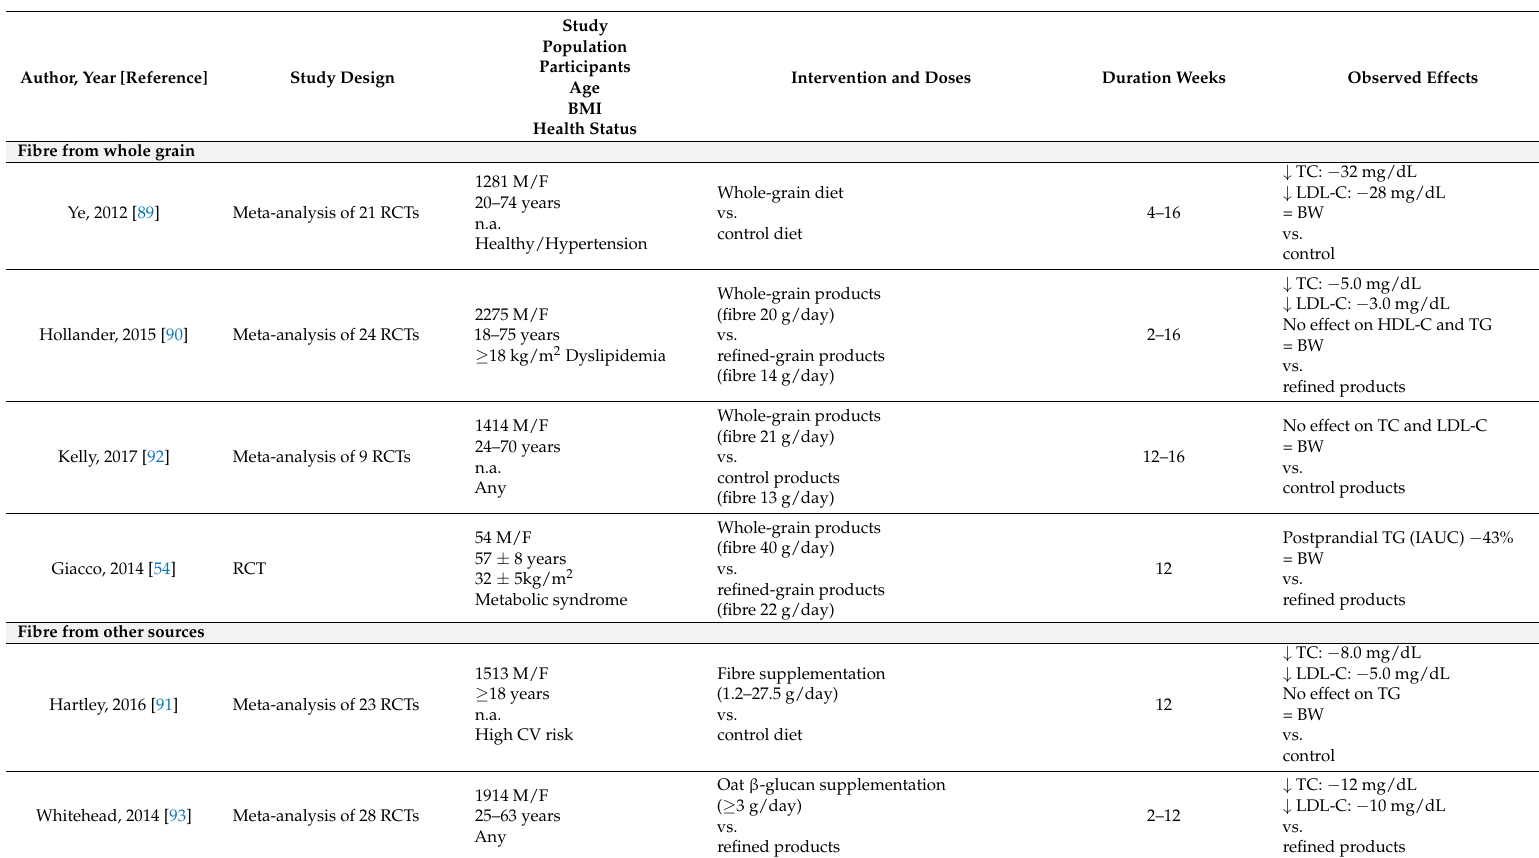
Table 5. Published meta-analyses of RCTs evaluating the effects of fibre from whole grain or other sources on serum lipids and two clinical trials also evaluating the postprandial lipid